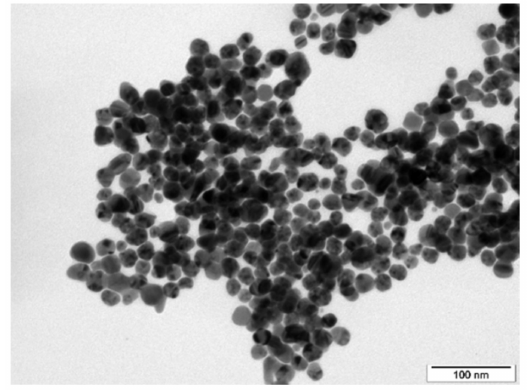
Figure 2. TEM image of electrochemically synthesized AgNPs colloid used for optomechanical processing onto the PEN and PEEK surface.